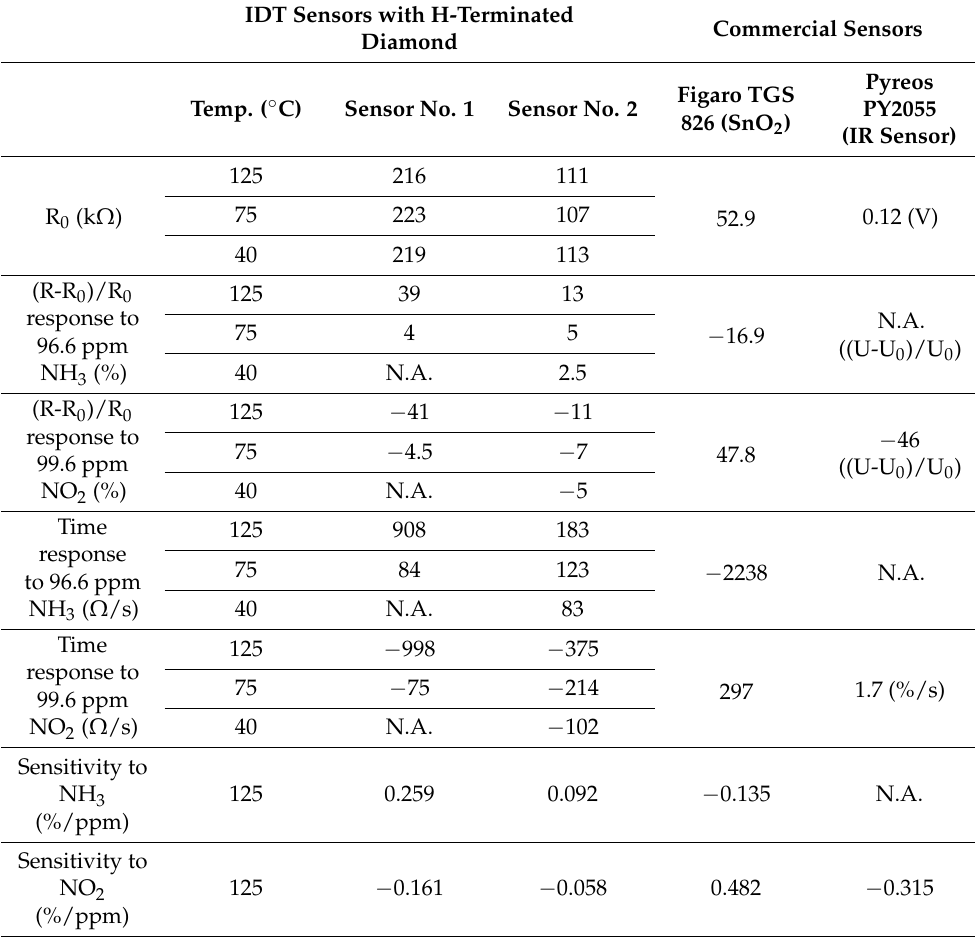
Figure 11. Time dependence of H-terminated NCD sensor’s response to three concentrations of ammonia (96.6 ppm, 48.3 ppm, and 0 ppm (synthetic air)) at 125 °C with a gas flow rate of 100 sccm. Table 1. Comparison of the responses and properties of the H-terminated NCD sensors with the TGS 826 and PY2055 commercial